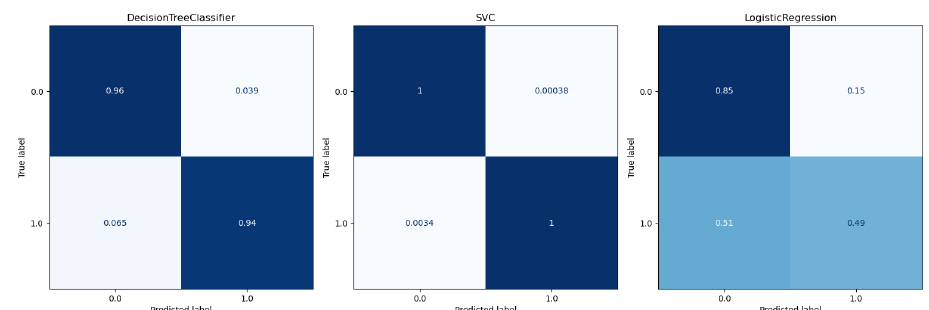
Figure 11. Confussion matrix for classifciation models.